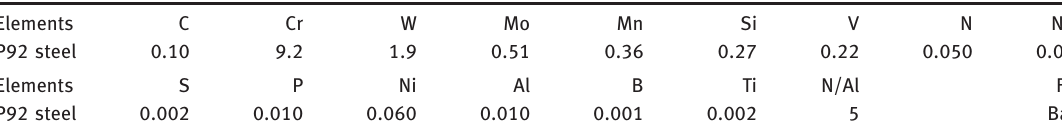
Table 1: Chemical composition (wt. %) of P92